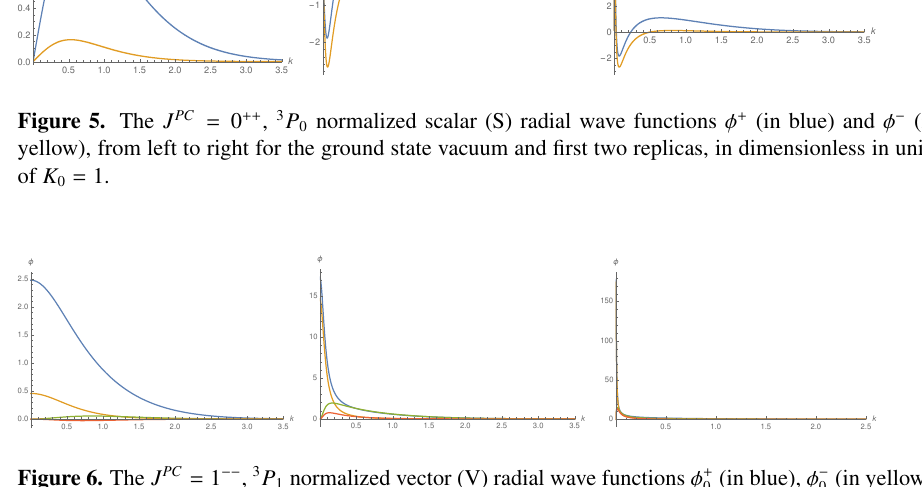
Figure 6. The J PC = 1 −− , 3 P 1 normalized vector (V) radial wave functions φ + φ + (in green) and φ − (in red) from left to right for the ground state vacuum and first two replicas, in 2 2 dimensionless in units of K 0 = 1.